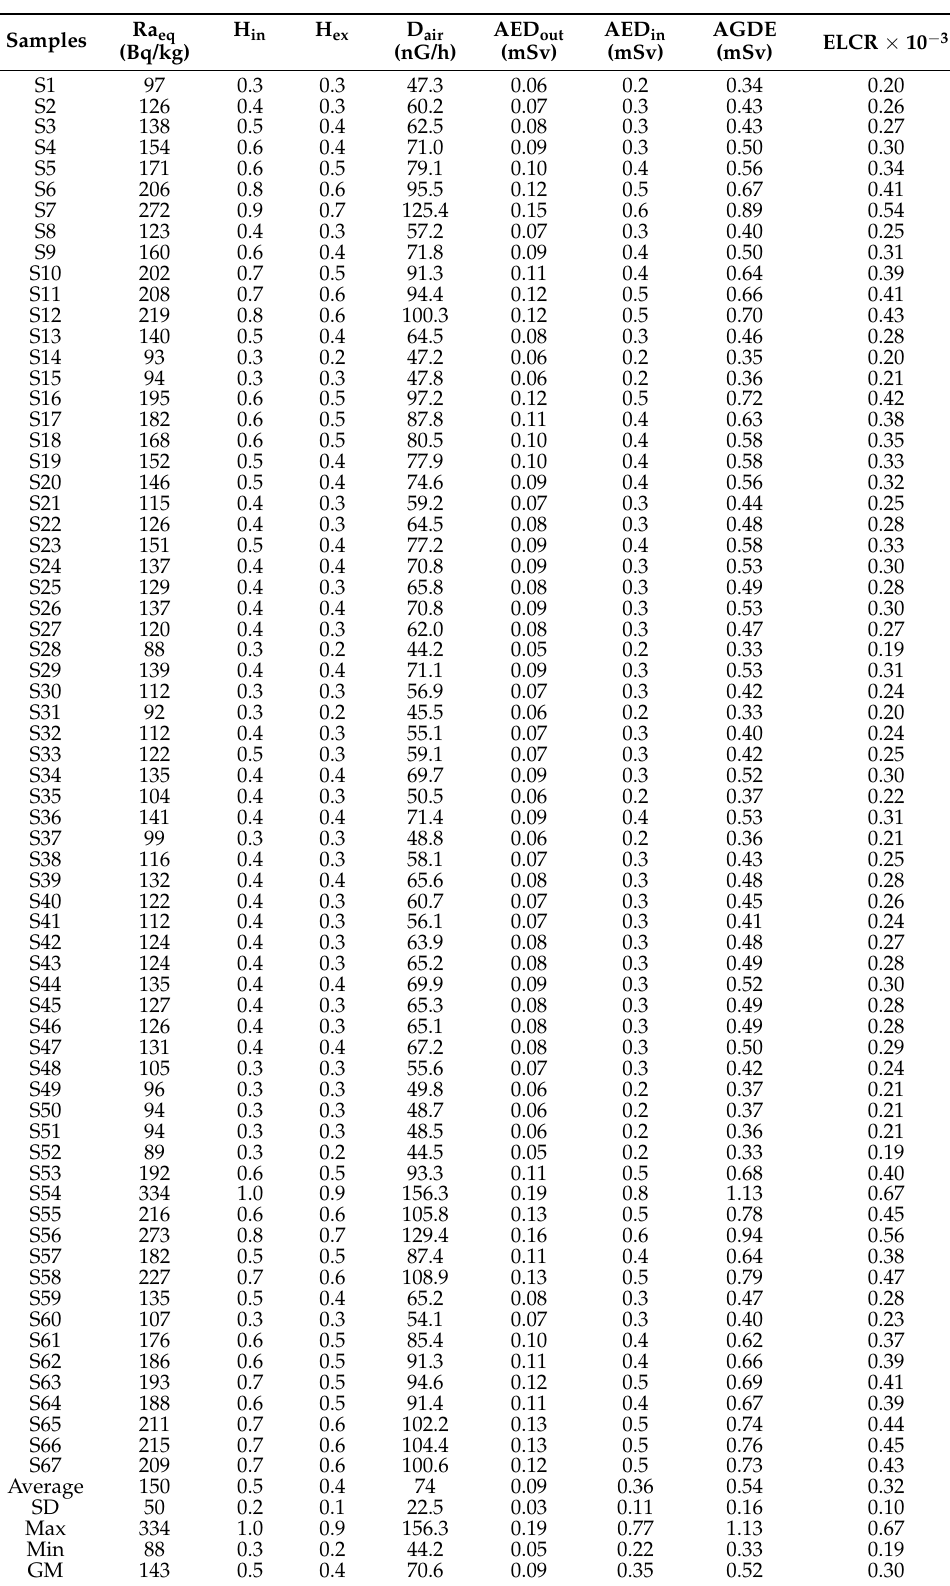
Table 4. Radium equivalent activity (Raeq), external hazard index (Hex), internal hazard index